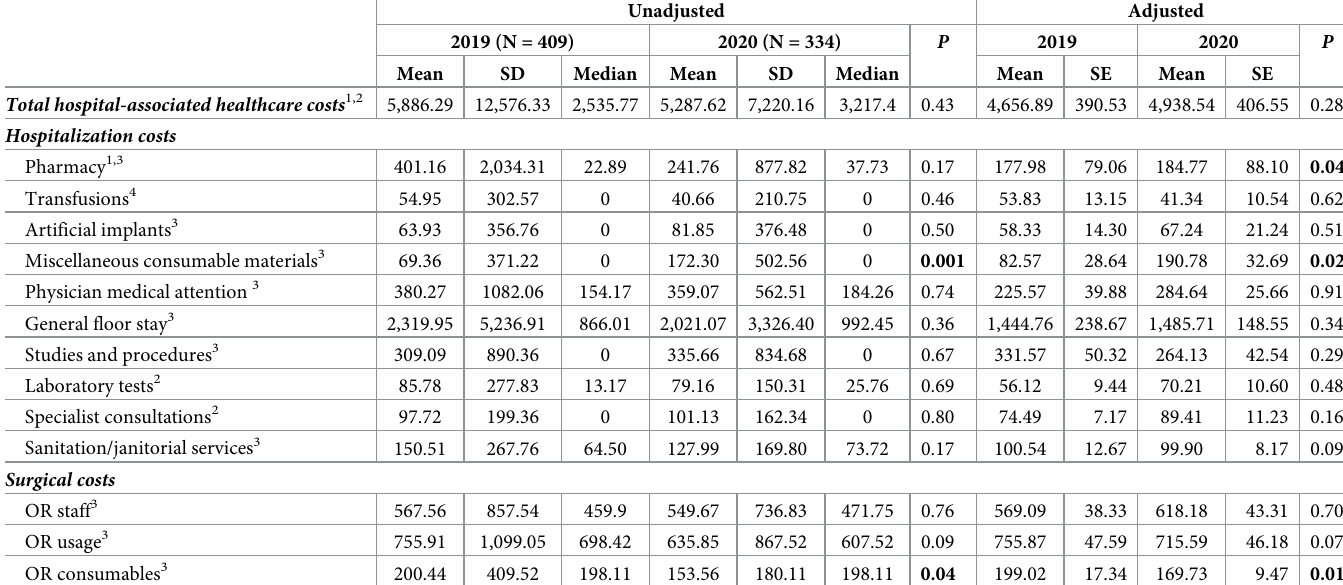
Table 3. Hospitalization and surgical